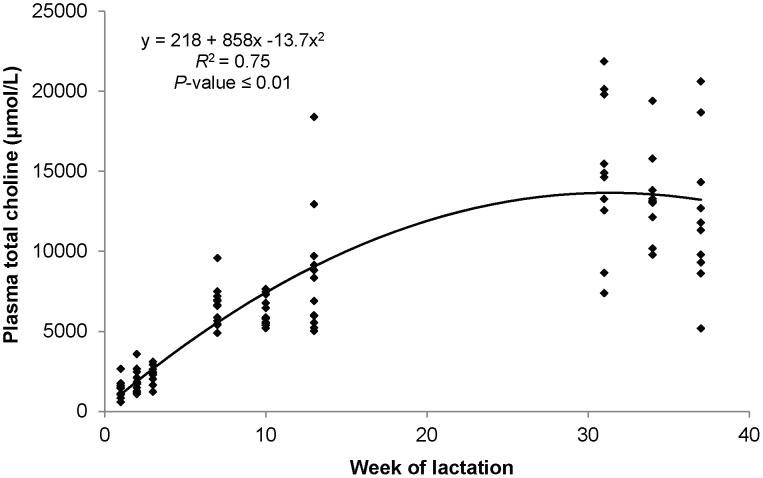
Relationship between total choline concentration in plasma and week of lactation.The standard errors for the intercept, linear and quadratic term were 564, 97.0, and 2.42, respectively.